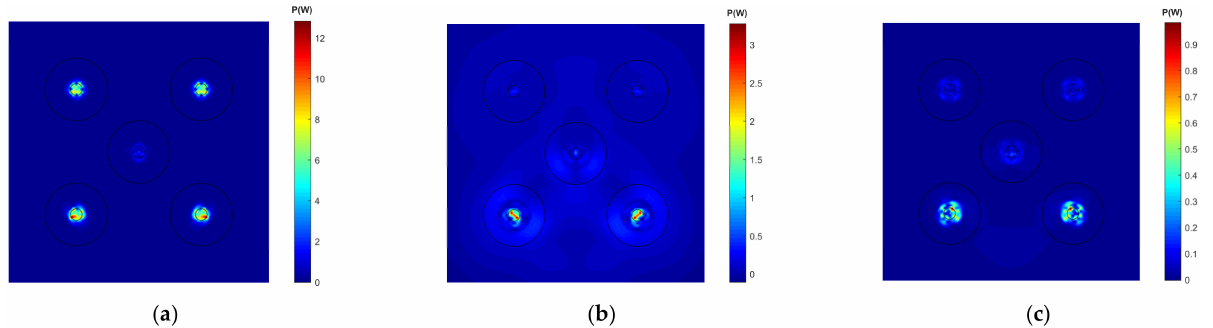
Figure A8. Structural intensity contours of ABHs with BC 2 at different frequencies: ( a ) 1000 Hz, ( b ) 1050 Hz, ( c ) 1100